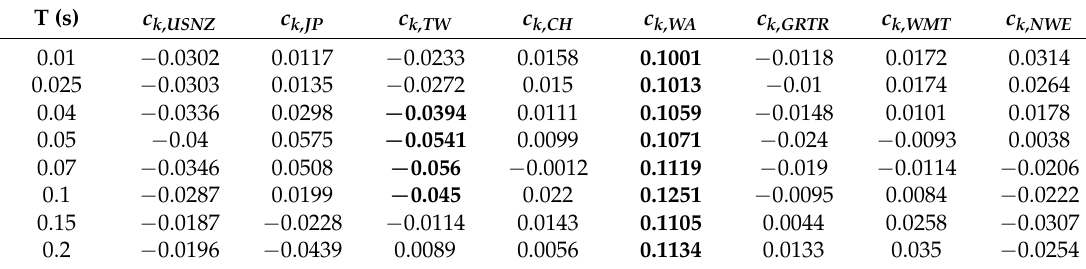
Table 3. Site model coefficients for regional effects.